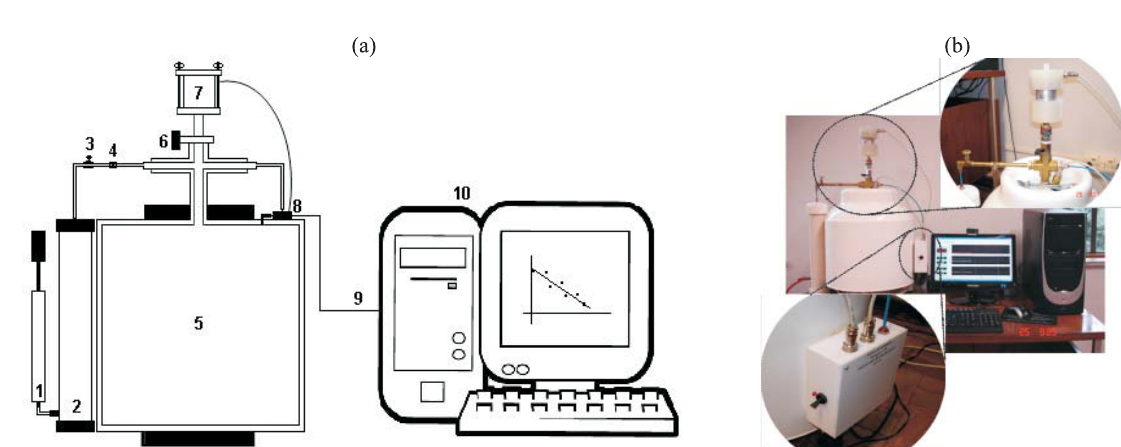
Figura 1. Diagrama esquemático (a) constituído por: 1: bomba de ar; 2: cilindro de desumidificação do ar preenchido com sílica-gel; 3: válvula de controle de fluxo; 4: válvula de escape para ajuste fino da pressão interna; 5: cilindro de ar; 6: válvula de controle de fluxo; 7: compartimento de alocação da amostra indeformada de solo; 8: sistema de aquisição de dados constituído por transdutor de pressão e sensores de temperatura e umidade; 9: cabo de transmissão de dados (DB 9); 10: microcomputador para processamento dos dados; e fotografia do equipamento para medida da permeabilidade intrínseca do solo ao ar